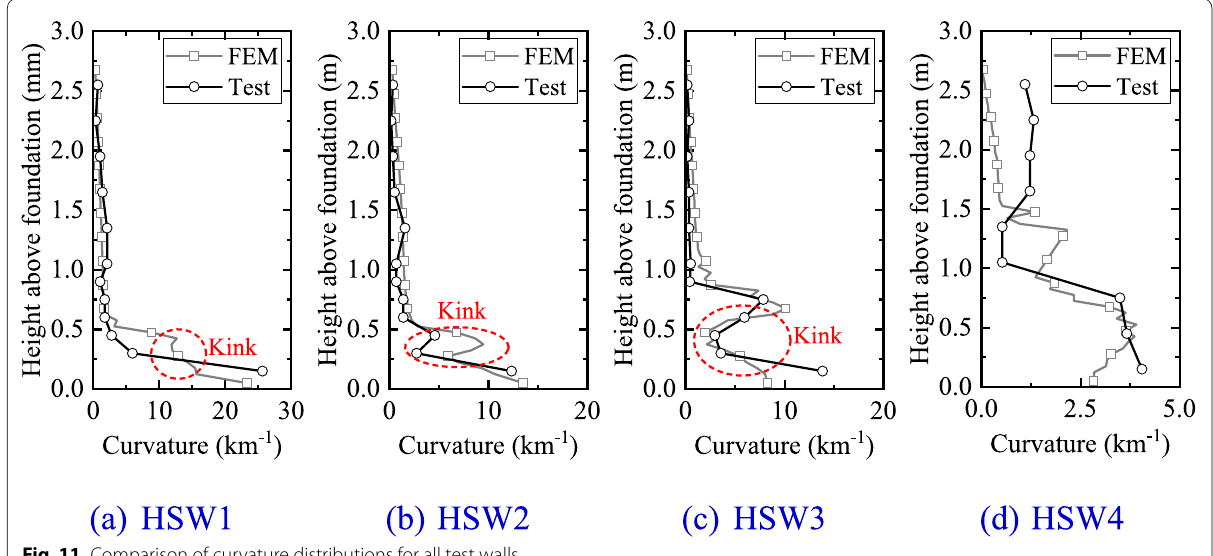
Fig. 11 Comparison of curvature distributions for all test